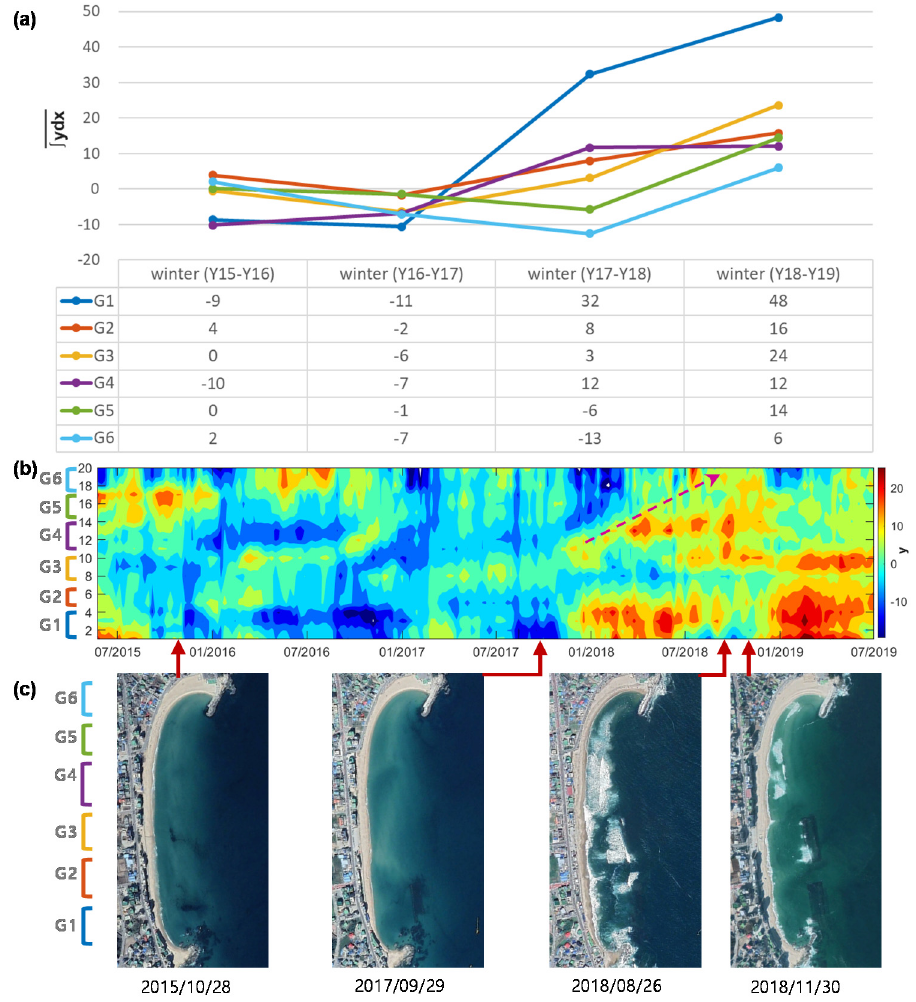
Figure 15. Annual winter changes in beach width by sector and spreading of nourished sediments: ( a ) Mean values of integrated beach width for each sector during every winter from 2015 to 2019. ( b ) Change over time of beach width showing spreading movement toward the G6 sector of nourished sediment in early 2018. ( c ) Aerial photographs of Bongpo at four different time steps during the observation period (taken from Google Earth).